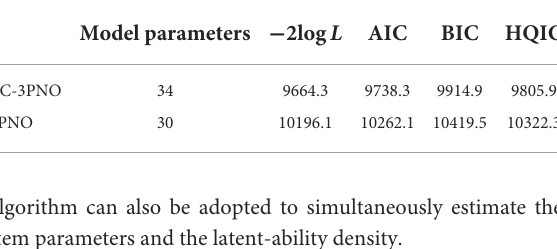
TABLE 7 Model selection results for the real data